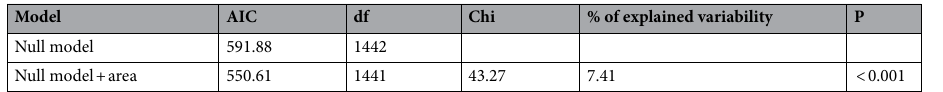
Table 4. The results of GLMM analysis ( lmer function). The effect of the study area on nest box occupancy (0/1) by boreal